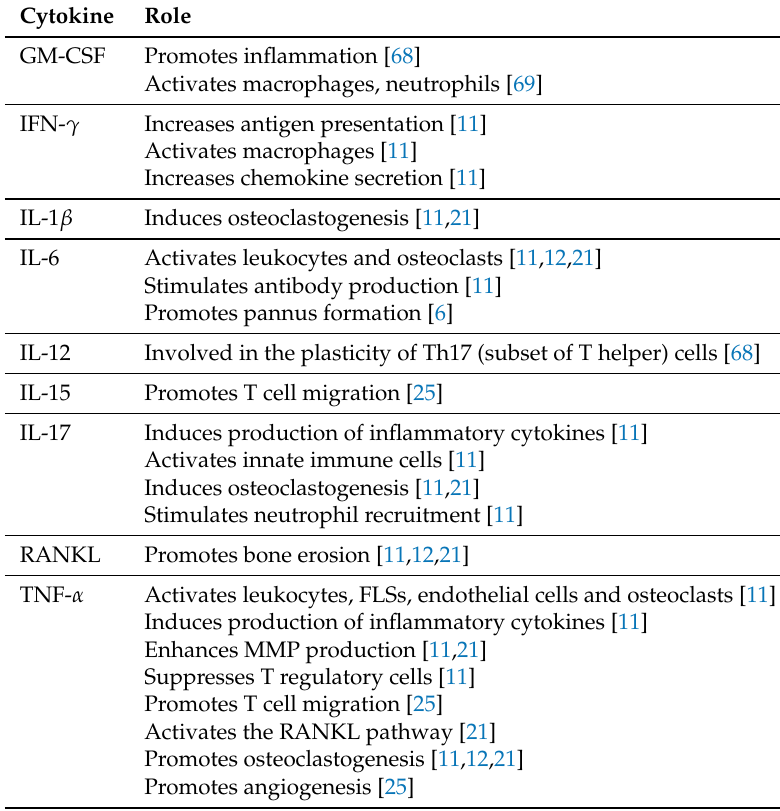
Table 1. Cytokines considered within mathematical models of RA and their biological